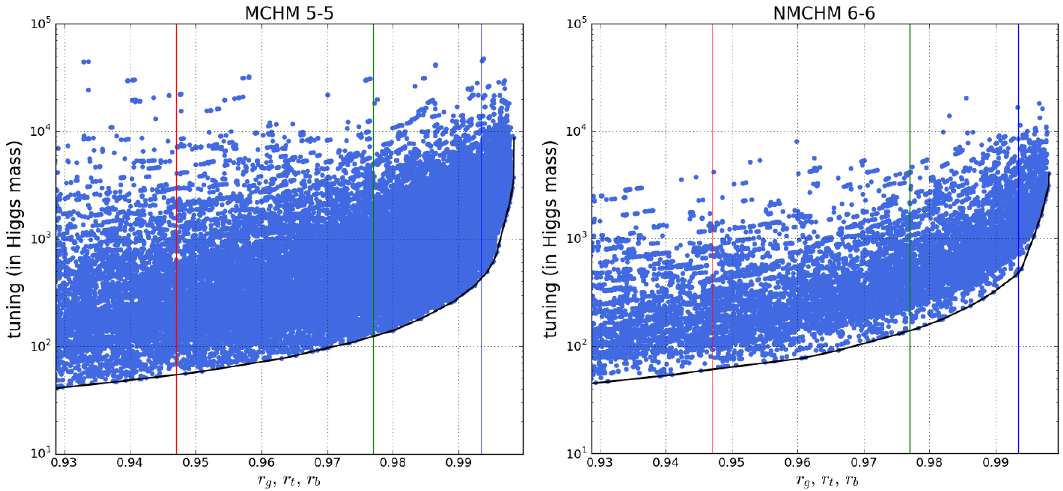
Figure 4. Comparison of the (cid:12)rst-order tuning (as de(cid:12)ned in equation (4.3)) contribution from the Higgs mass, in the Higgs-gluon, -top and -bottom coupling deviation. The red line shows the expected precision of a 250 GeV ILC, green a 500 GeV ILC, and blue a high-luminosity 1 TeV ILC.